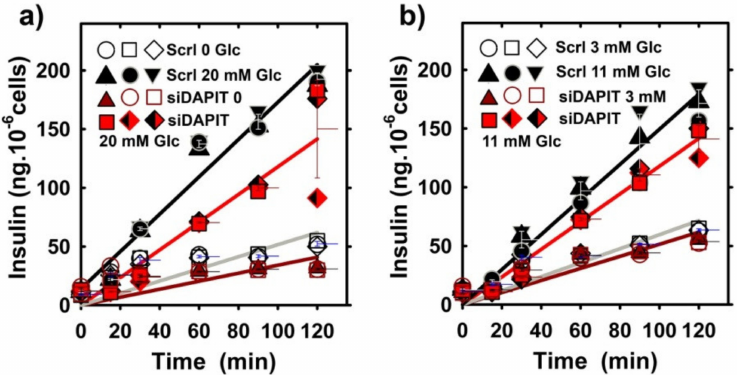
Figure 8. Insulin release in INS-1E Scrl cells vs. DAPIT-silenced cells. Time course of the accumulated insulin with no addition ( a ) and after the addition of 3-mM ( b ), 11-mM ( b ) and 20-mM glucose ( a ). Data originate from N = 3 time courses for each condition. Legend: “Scrl“, INS-1E Scrl cells; “siDAPIT”, DAPIT-silenced INS-1E